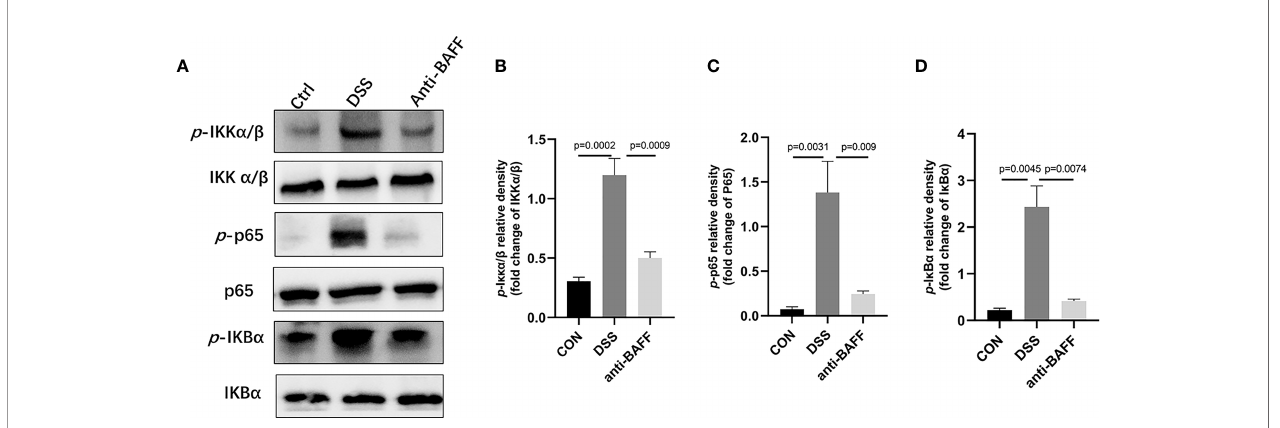
FIGURE 5 | Anti-BAFF antibody inhibited the activation of NF- k B in DSS-induced experimental chronic colitis in mice. (A) Representative WB analysis of phospho- IKK a / b , IKK a / b , phospho-NF- k B p65, NF- k B p65, phospho-IKB a , IKB a in colon tissues. (B) Histogram of relative expression of p-IKK a / b in colon tissues (n = 6 – 8 per group). (C) Histogram of relative expression of p-p65 in colon tissues (n = 6 – 9 per group). (D) Histogram of relative expression of p-IKB a in colon tissues (n = 6 – 9 per group). Ctrl,